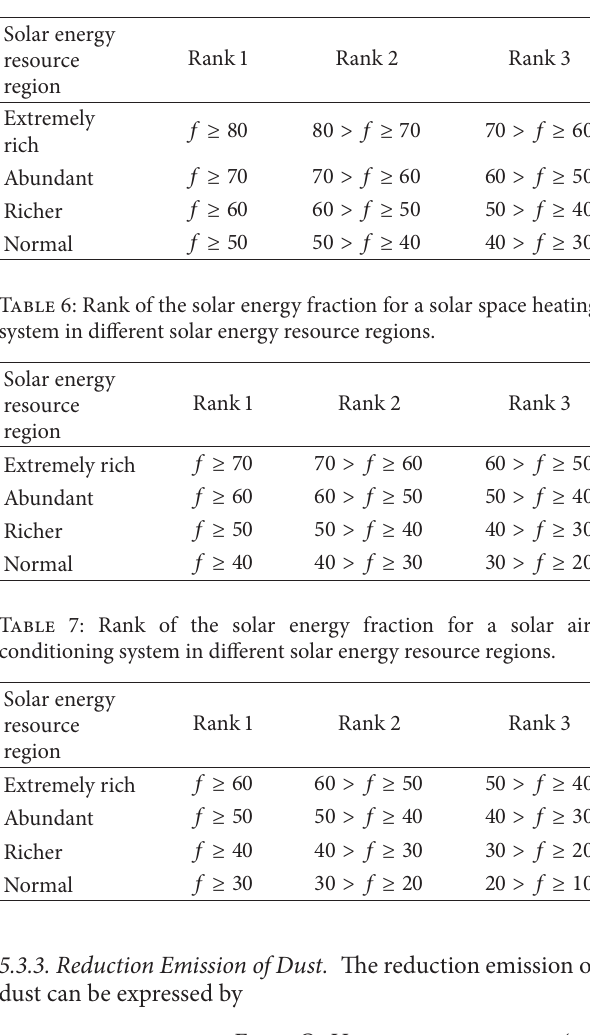
Table 4: Operating efficiency of a heating resource using conven- tional energy.